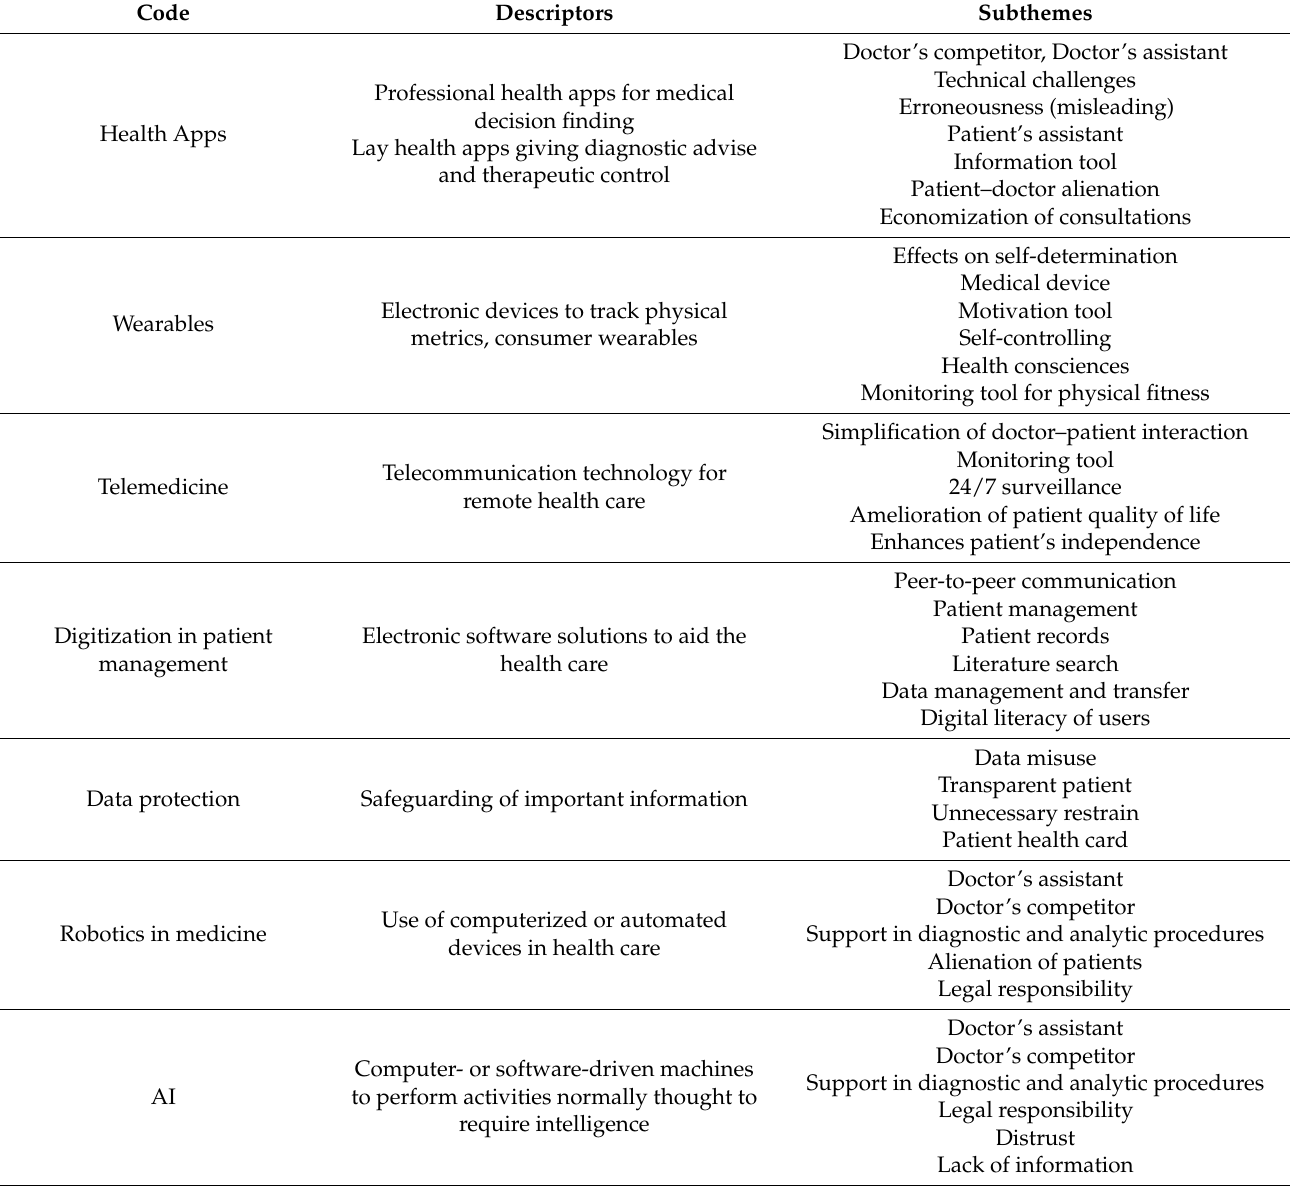
Table 2. Codes used in the qualitative study